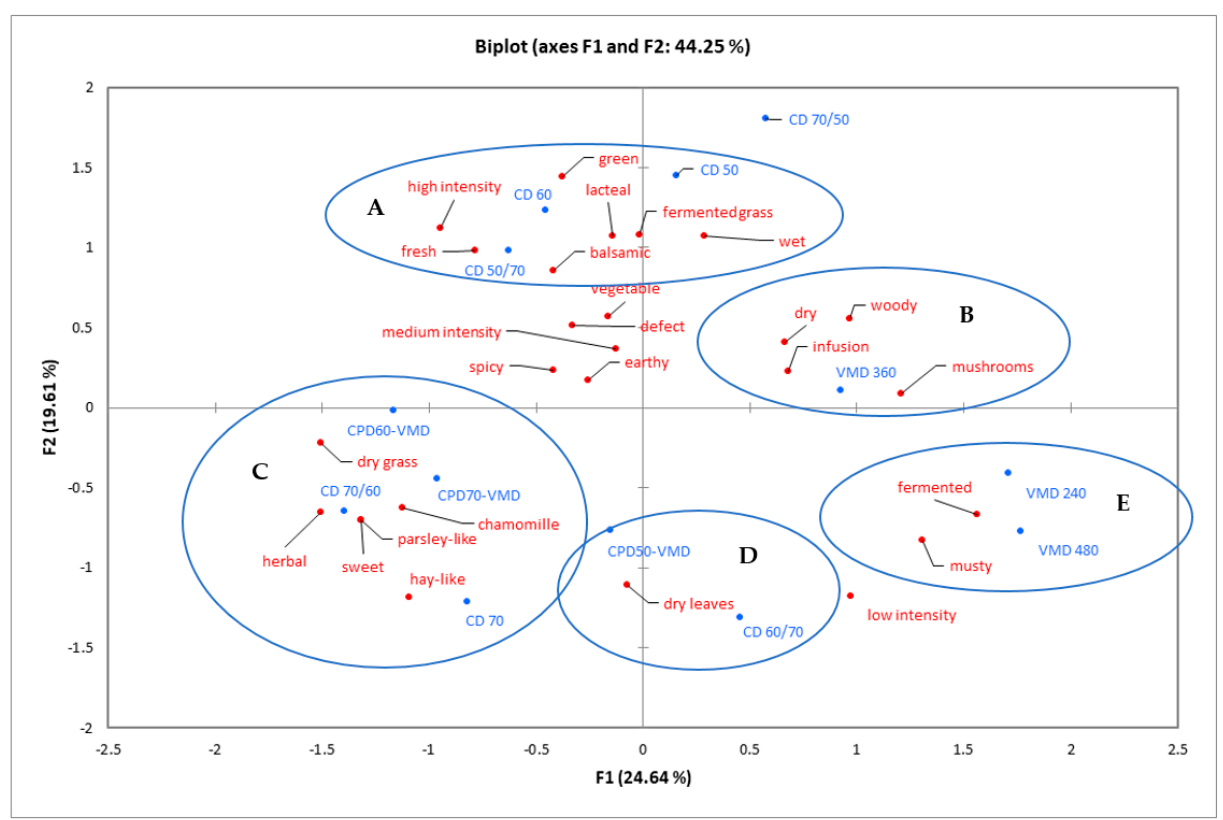
Figure 2. Napping test results for cilantro treated with various drying methods presented as biplot generated with MFA, which explains 44.25% of the variance. Samples were grouped in the napping test according to the groups established in a clustering dendrogram prepared using Pearson’s correlation based on the unweighted average.